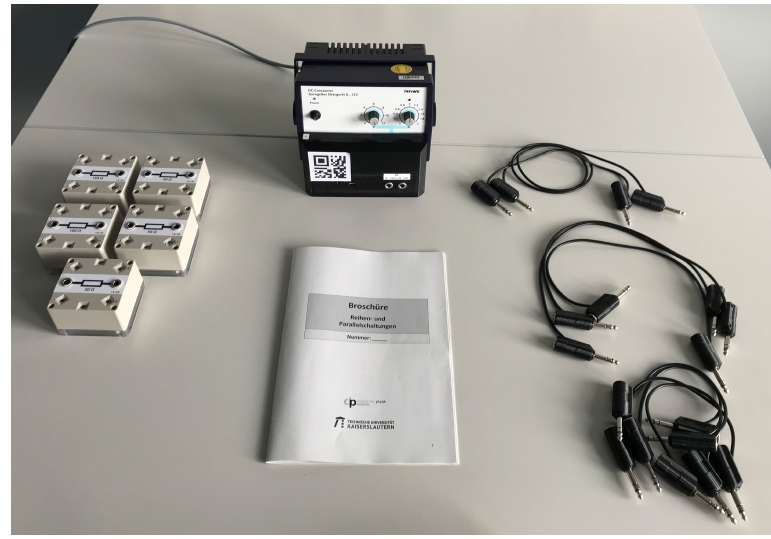
Figure 7. Photo of the experiment setup of the usability evaluation.